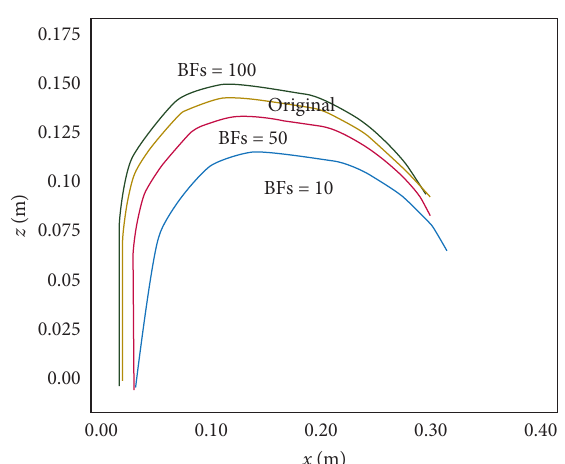
Figure 3: The influence of the number of DMPs weight on the curve.